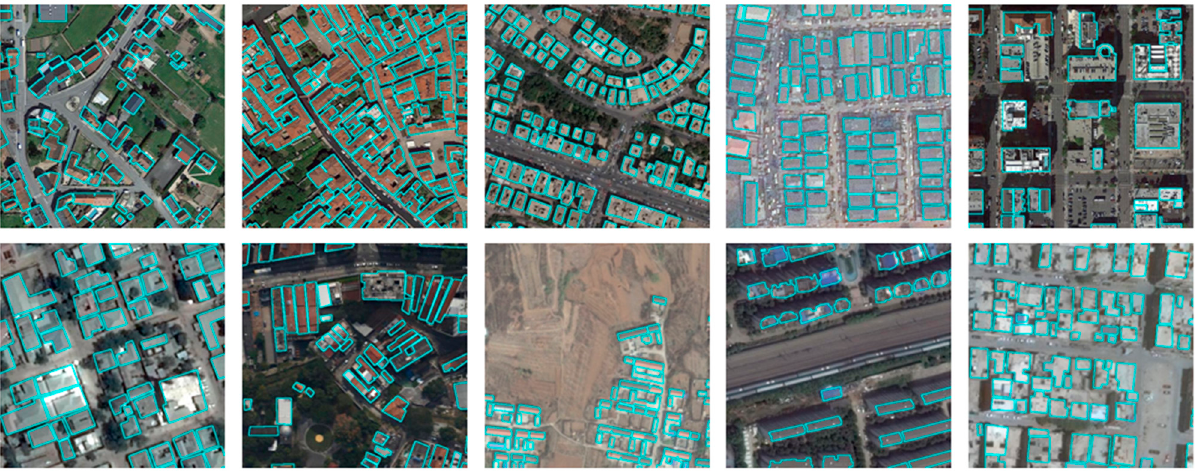
Figure 6. Some examples of WHU Satellite Dataset I. The lime green color indicates the building outline.